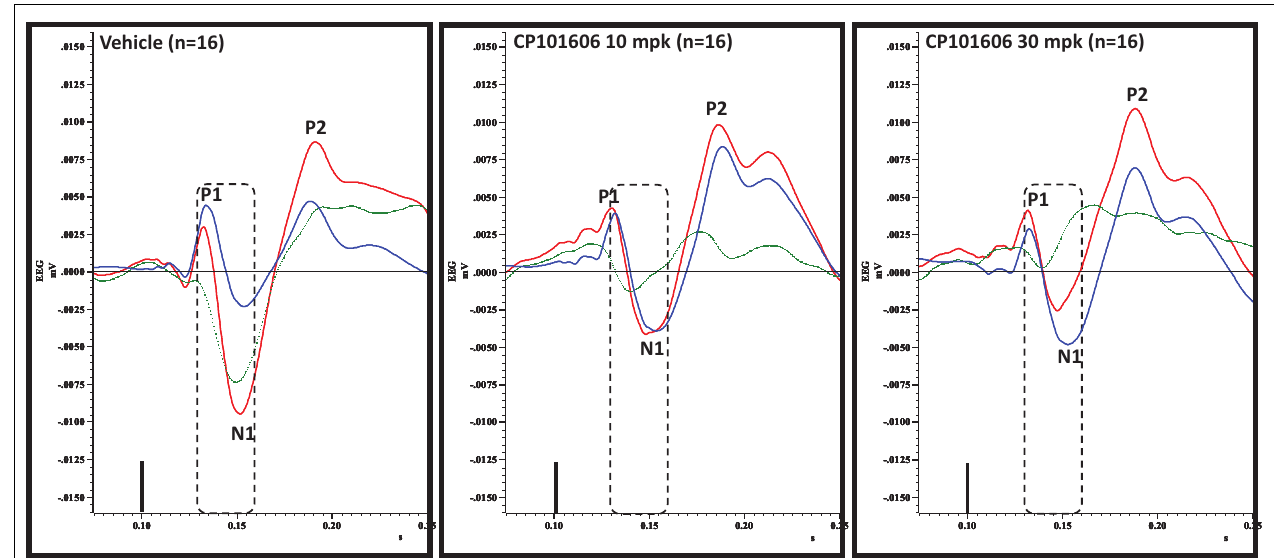
FIGURE 8 | Overlay of standard (blue), deviant (red) and difference wave (deviant-standard; green) ERPs approximately 60min after vehicle or CP-101606 (10 or 30mg/kg) treatment is shown . Notice a well-defined negativity in the difference wave 30–60ms post-stimulus onset (dashed box) after vehicle treatment only.